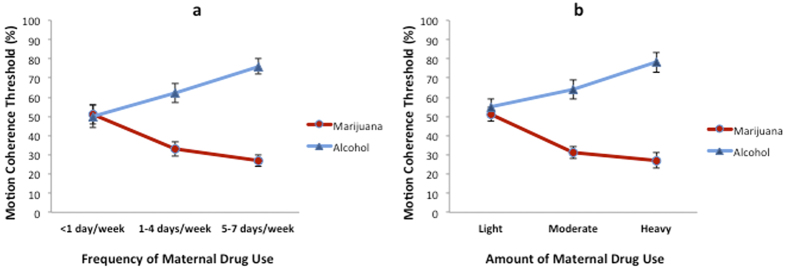
The relationship between motion coherence thresholds and the (a) frequency and (b) amount of maternal marijuana or alcohol use.The red and blue lines indicate maternal marijuana and alcohol use, respectively. Data points in panel (a) indicate mean motion coherence thresholds for children who were prenatally exposed to marijuana or alcohol <1 day/week (marijuana n = 6, alcohol n = 10), 1–4 days/week (marijuana n = 5, alcohol n = 14), or 5–7 days/week (marijuana n = 9, alcohol n = 22). Data points in panel (b) indicate mean motion coherence thresholds for children whose marijuana or alcohol exposure on each occasion was light (marijuana, <1 joint, n = 6; alcohol, <2 drinks, n = 19), moderate (marijuana, 1–2 joints, n = 7; alcohol, 2–5 drinks, n = 9), or heavy (marijuana, >2 joints, n = 7; alcohol, >5 drinks, n = 18). Drug use data are maternal self-report; see methods for further details. The error bars indicate standard error of the mean. Other drug use (yes/no for methamphetamine and nicotine), sex, ethnicity, stereoacuity, visual acuity, and verbal IQ were controlled for in the multiple regression model.